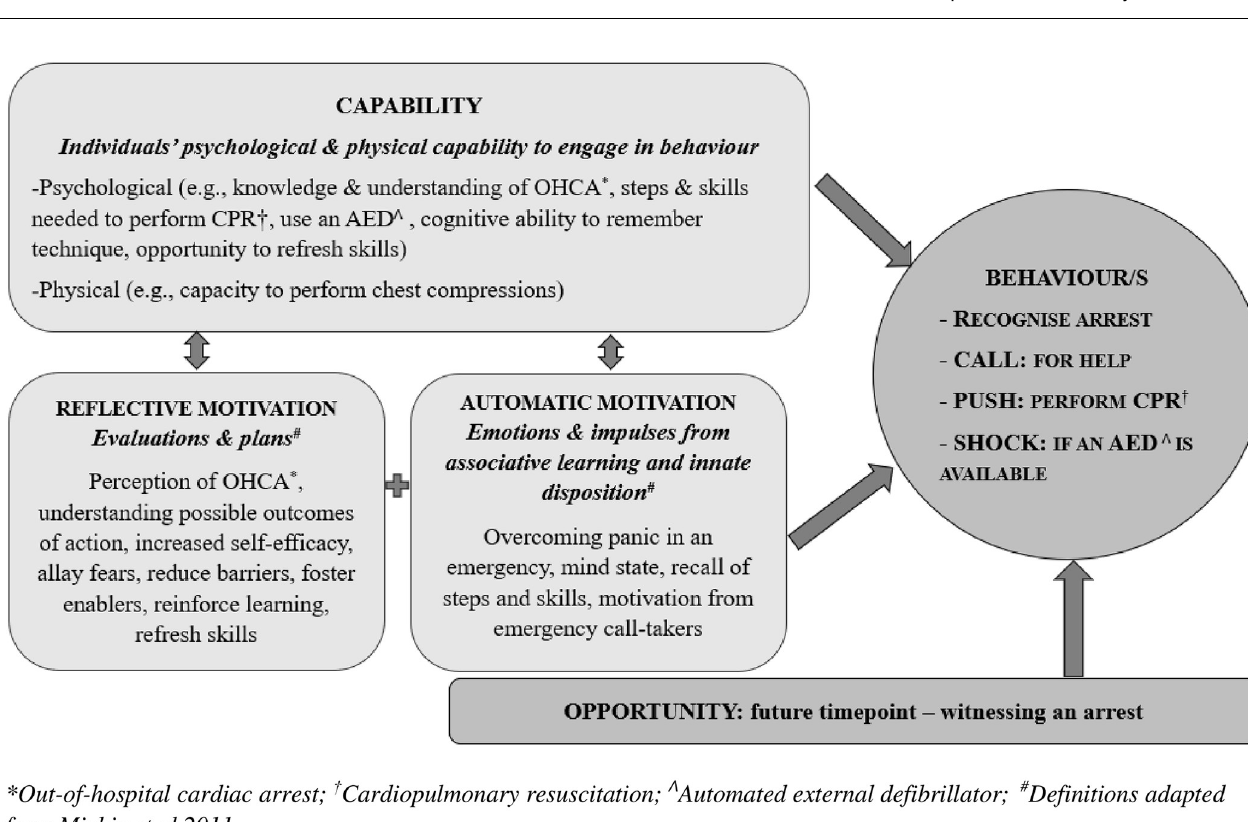
Fig 1. Theory-guided approach informing intervention development (image concept and flow adapted from COM-B model) [18].